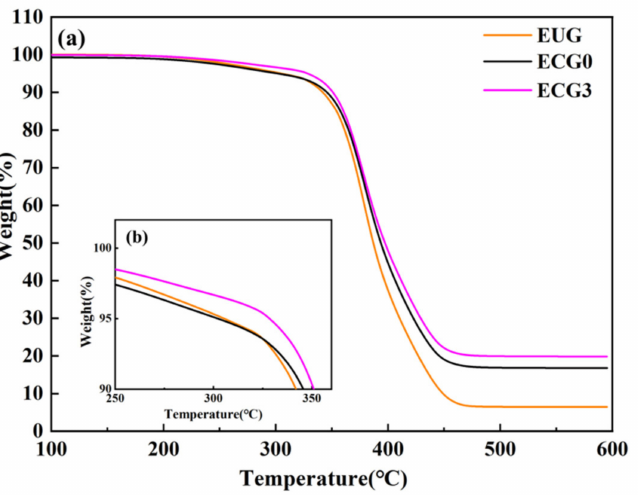
Figure 10. ( a ) Thermogravimetric curves of CNT/GNP/EUG composites. ( b ) Enlarged view of thermogravimetry at 100–90%. Table 2. Thermal characteristics data of CNT/GNP/EUG composites. Samples